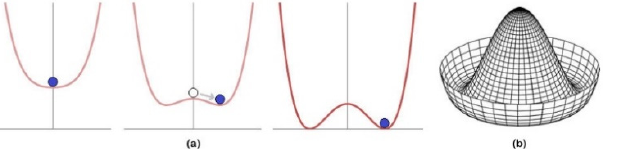
Figure 6. Intuitive representation of the Goldstone theorem. ( a ) The principle of SSB. ( a ) Left: the ground state of the system (minimum of the energy potential function) is not at 0-energy equilibrium. ( a ) Center: This induces the possibility that, despite the overall symmetry being conserved, the system (blue ball) can “choose” between different (two, in the example) states, each “locally” breaking the global symmetry. ( a ) Right: Indeed, the system stays in one of the two available ones at the same ground state to determine an SSB. ( b ) Effectively, at the QV ground state, there are infinitely many possible SSBs to determine the classical “sombrero hat” energy potential diagram of the Goldstone theorem.